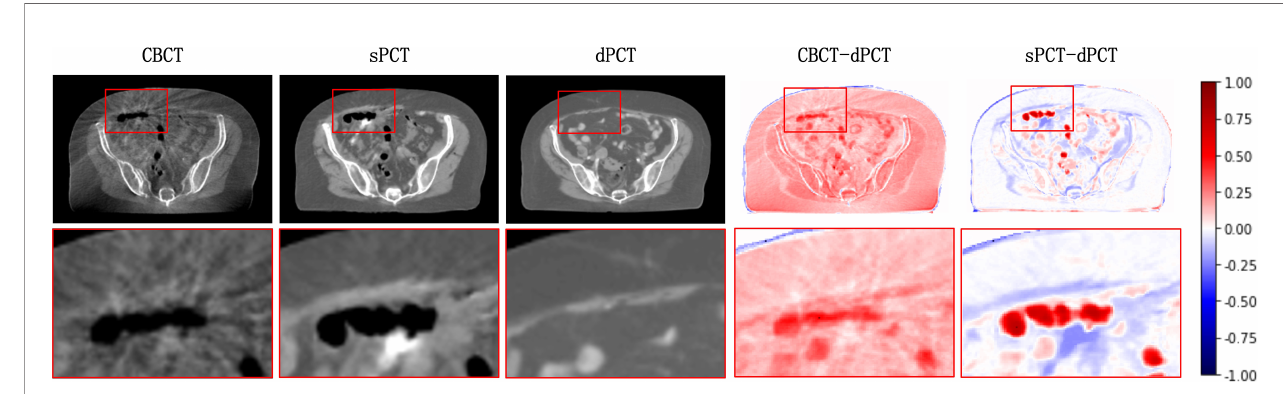
FIGURE 5 | Artifact correction comparison. From left to right are CBCT, sPCT, dPCT, CBCT- dPCT, and sPCT - dPCT. The second row shows an enlarged version of the red rectangle of the image on the fi rst row.